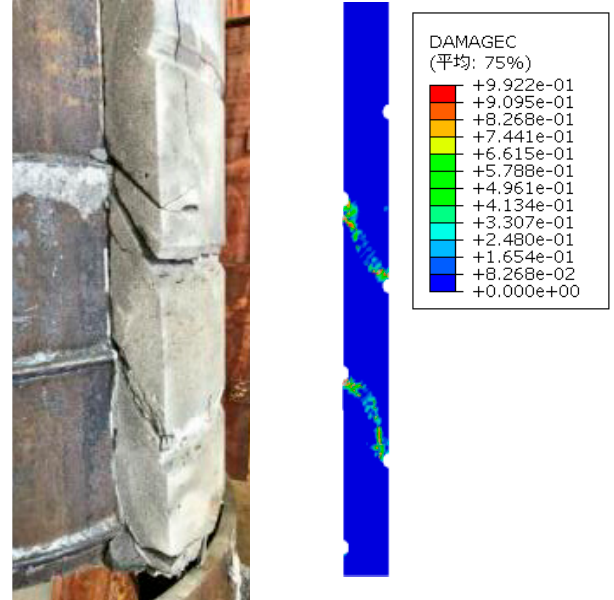
Figure 12. Comparison of test load–displacement curves: ( a ) S75; ( b ) S50; ( c ) S100; ( d ) H2.5; ( e ) T38;